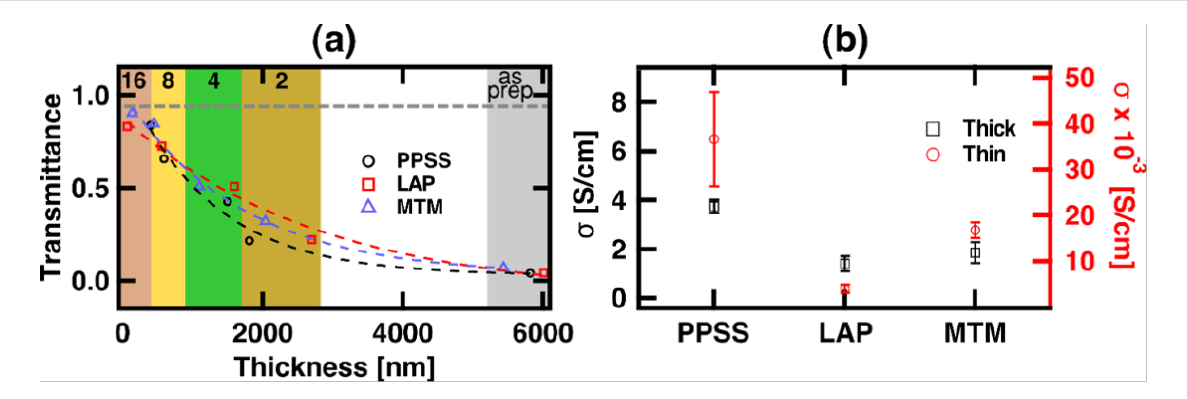
Figure 1: (a) Summary of optical characterization. The transmittance for the different samples is plotted versus the thickness for a wavelength λ = 550 nm. The colored areas correspond to the different dilution factors, which are specified at the top of the figure. The dashed grey line shows the transmittance of the substrate (glass slide). All the results are fitted to exponential functions, shown in dashed lines. (b) Electrical conductivity summary showing the average and one standard deviation range, acquired using C-AFM. The results for the thick and thin samples are plotted on dif- ferent vertical